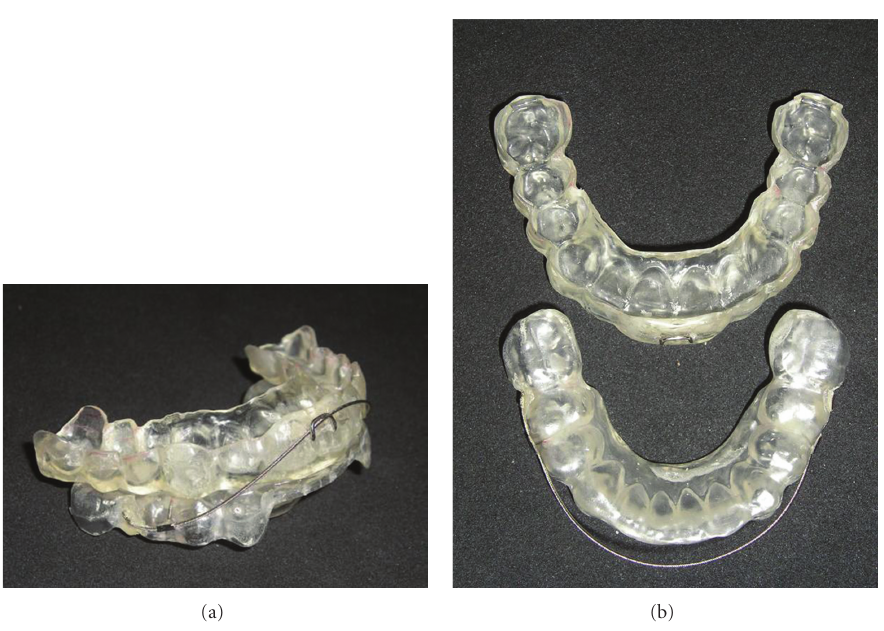
Figure 2: (a) Two-piece MAA (lateral view), (b) upper and lower plates.